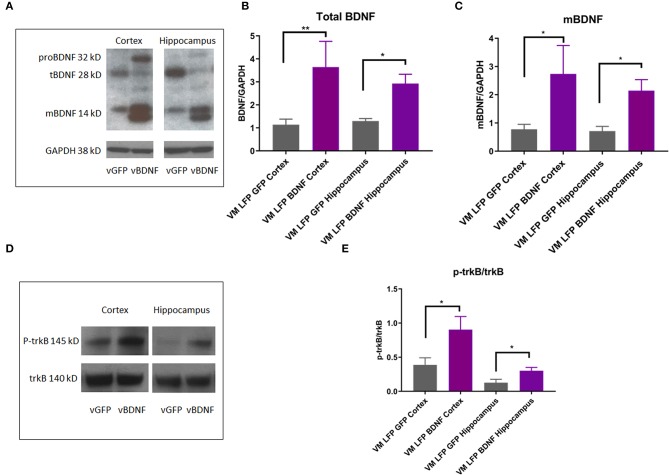
AAV-BDNF injection causes an increase in total BDNF, mature BDNF, and p-trkB expression relative to control AAV-GFP injection in the cortex and hippocampus at 21 DPI in injured Val66Met mice. (A) Representative Western Blot showing BDNF expression in the cortex and hippocampus after injury. Each lane represents one animal. (B) Quantification of total BDNF protein levels ± SEM at 21 DPI in the cortex and hippocampus. (C) Quantification of mature BDNF protein levels ± SEM at 21 DPI in the cortex and hippocampus. All data is first normalized to GAPDH to control for protein loading ± SEM, n = 6. (D) Representative Western Blot showing p-trkB expression in the cortex and hippocampus after injury. Each lane represents one animal. (E) Quantification of p-trkB protein levels at 21 DPI in the cortex and hippocampus. All data is first normalized to trkB to control for protein loading ± SEM, n = 4. *p < 0.05, **p < 0.01, ANOVA Fisher's PLSD post-hoc test relative to indicated groups.